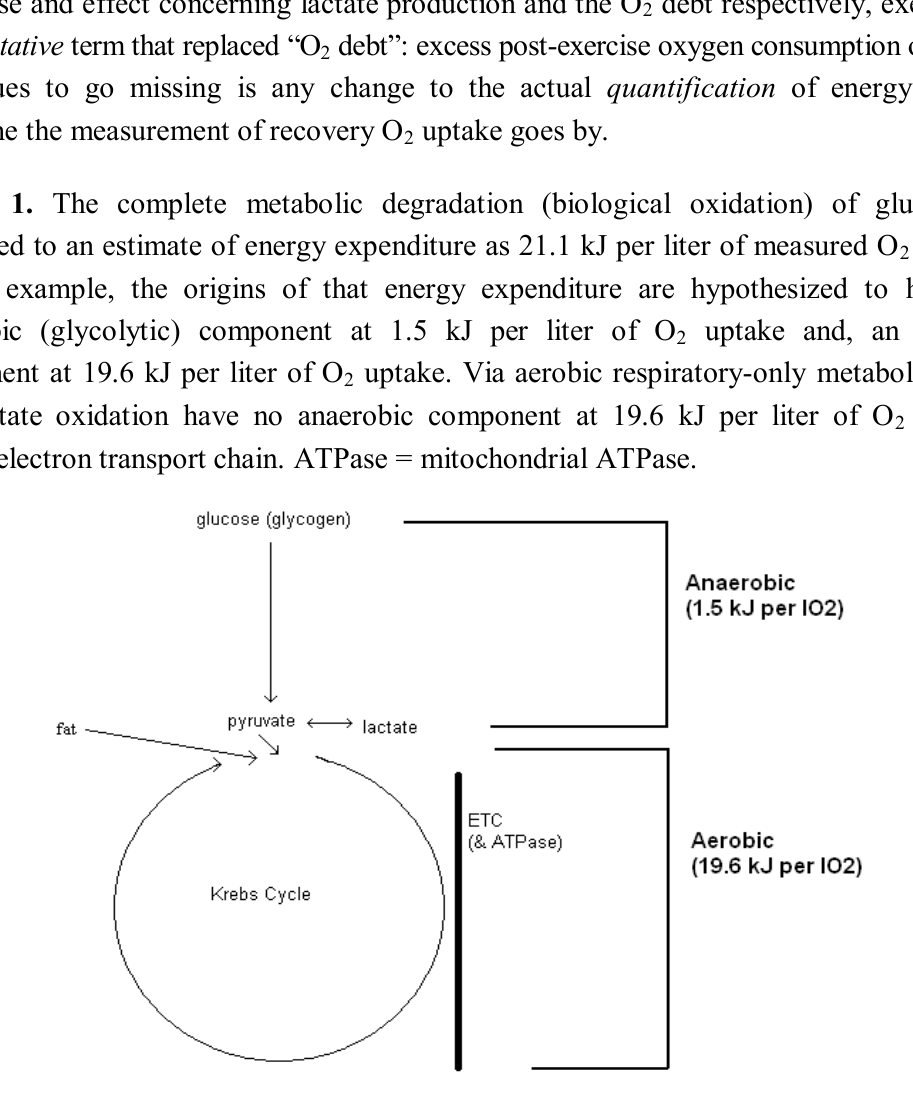
Figure 2. Oxygen uptake for six-minutes of low-intensity continuous steady state exercise with recovery is depicted. Anaerobic energy costs are shown in black as an oxygen deficit at the start of exercise, as it takes time to achieve a steady state O uptake. After exercise, 2 recovery takes place where O uptake returns to resting levels. Traditionally called the O 2 2 debt, the name was changed to excess post-exercise oxygen consumption (EPOC) in a qualitative attempt to dismiss lactate as being causal to recovery O uptake 2